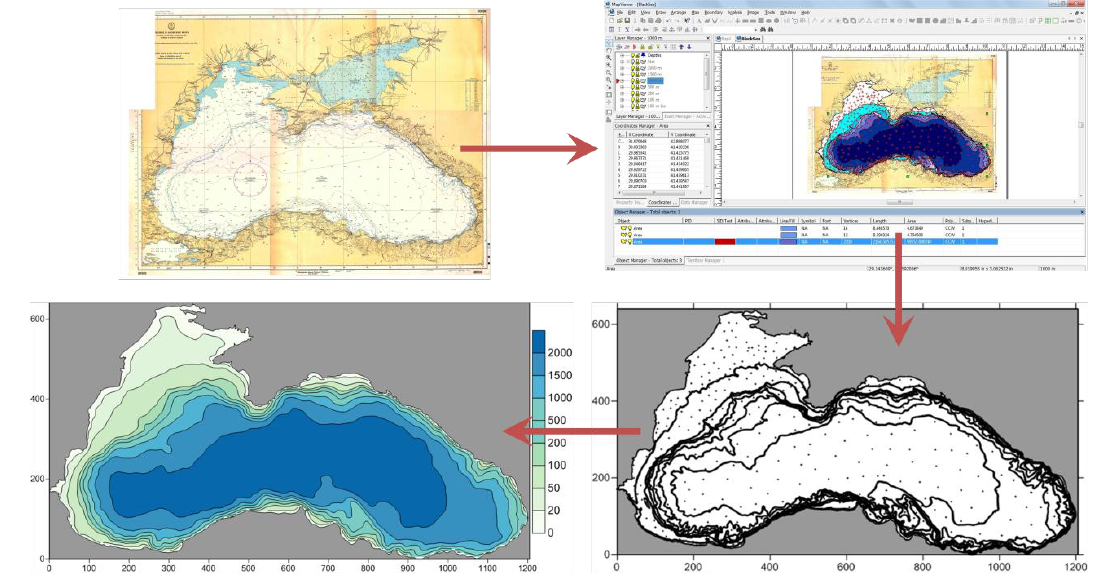
Figure 1. Schematic representation of the process of creating a rectangular matrix by means of digitizing a scanned map.